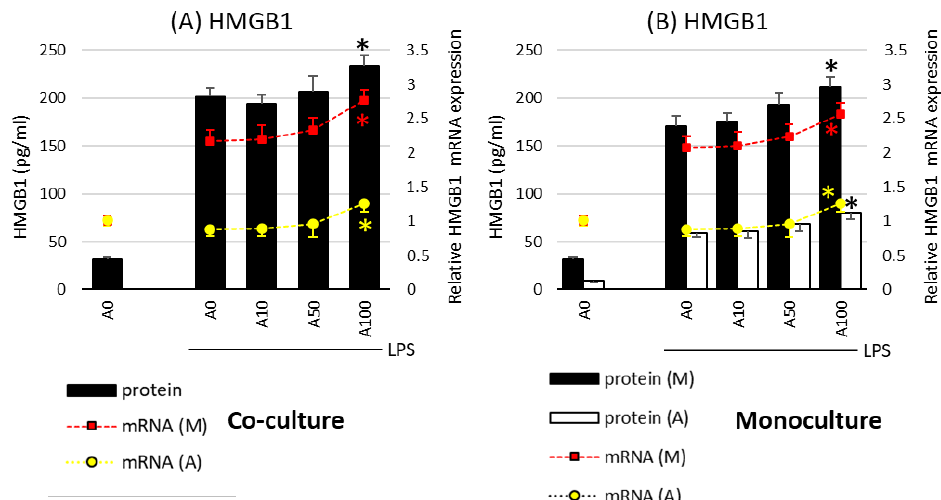
Figure 3. Effects of asprosin on lipopolysaccharide (LPS; 100 ng/mL)-induced cytokine mRNA expression and release of high-mobility group box-1 protein (HMGB1) in adipocyte “A” and macrophage “M” monocultures ( A ) and adipocyte–macrophage cocultures ( B ) on the 21st day of differentiation. The results are expressed as mean + standard deviation (SD) from five independent experiments. Statistical significance ( p < 0.05) was determined by the Duncan t -test. The asterisk (*) above the bar denotes statistically significant differences in protein or mRNA levels, calculated relative to the A0 + LPS control group. Cells: (M) macrophages; (A)